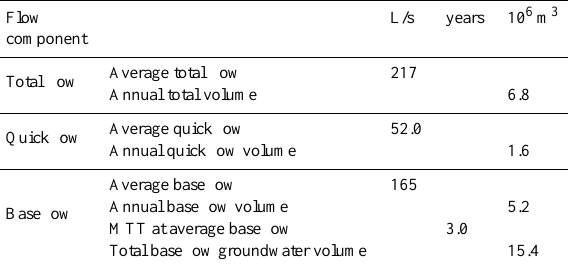
Fig. 8. Toenepi baseflow and quickflow components, together with (a) rainfall, (b) simulated mean transit time of the baseflow component, Figure 8. Toenepi baseflow and quickflow components, together with a) rainfall, b) simulated 5 and (c) simulated (curves) and measured (points) silica, nitrate, and phosphate concentrations. Shaded areas in (b) indicate periods with mean transit time of the baseflow component, and c) simulated (curves) and measured 6 quickflow run-off. Data points in (c) are measured data; full circles for SiO 2 are data points with age data listed in Table 1; hollow circles (points) silica, nitrate, and phosphate concentrations. Shaded areas in b) indicate periods with 7 are additional SiO 2 data from Stenger et al. (2010), and NO 3 and PO 4 are data measured at the catchment outflow weir by NIWA. quickflow run-off. Data points in c) are measured data; full circles for SiO 2 are data points 8 with age data listed in Table 1; hollow circles are additional SiO 2 data from Stenger et al. 9 Table 2. Flow components and volumes for the Toenepi (under review), and NO 3 and PO 4 are data measured at the catchment outflow weir by NIWA. 10